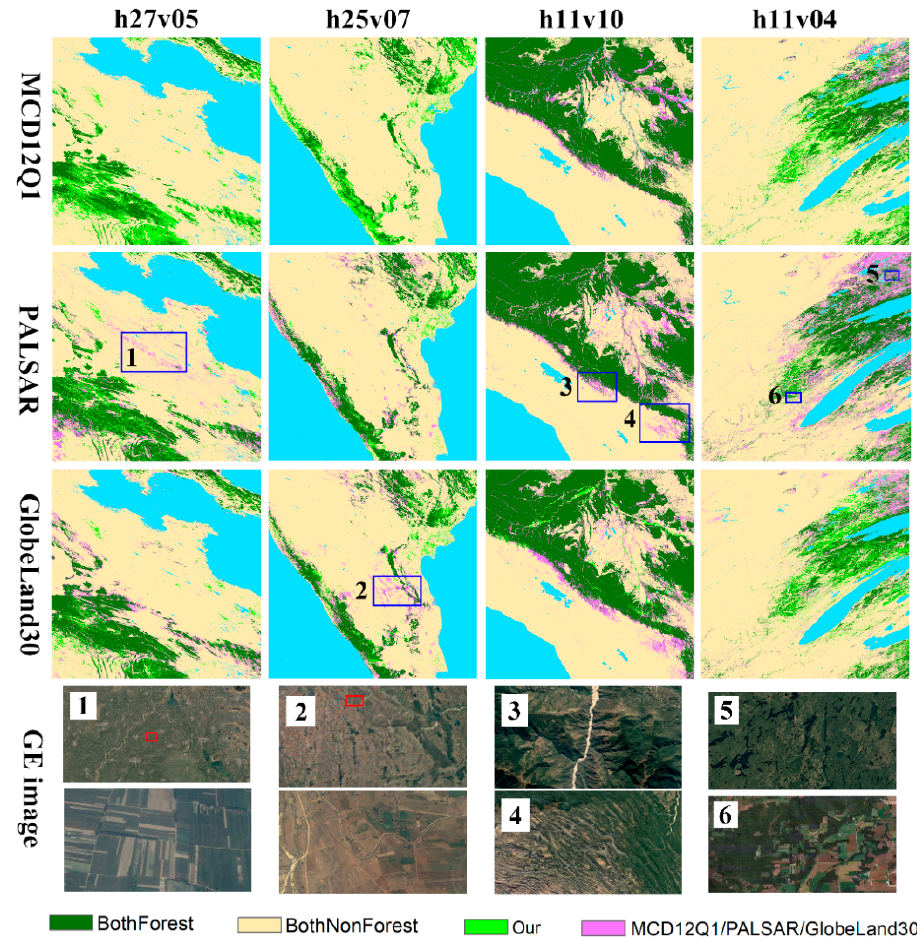
Figure 6. Comparison of the extracted forest cover maps with MCD12Q1, PALSAR FNF and GlobeLand30 products in 2010 for h27v05, h25v07, h11v10 and h11v04. The gray and blue colors refer to non-vegetated areas and waterbodies. Google Earth (GE) high-resolution images are also shown for six subregions.